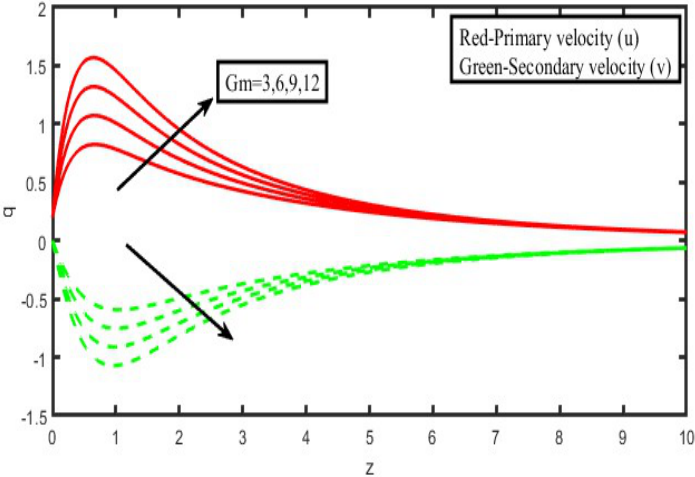
Figure 3. Velocity profiles for u and v for modified Grashof number (Gm).